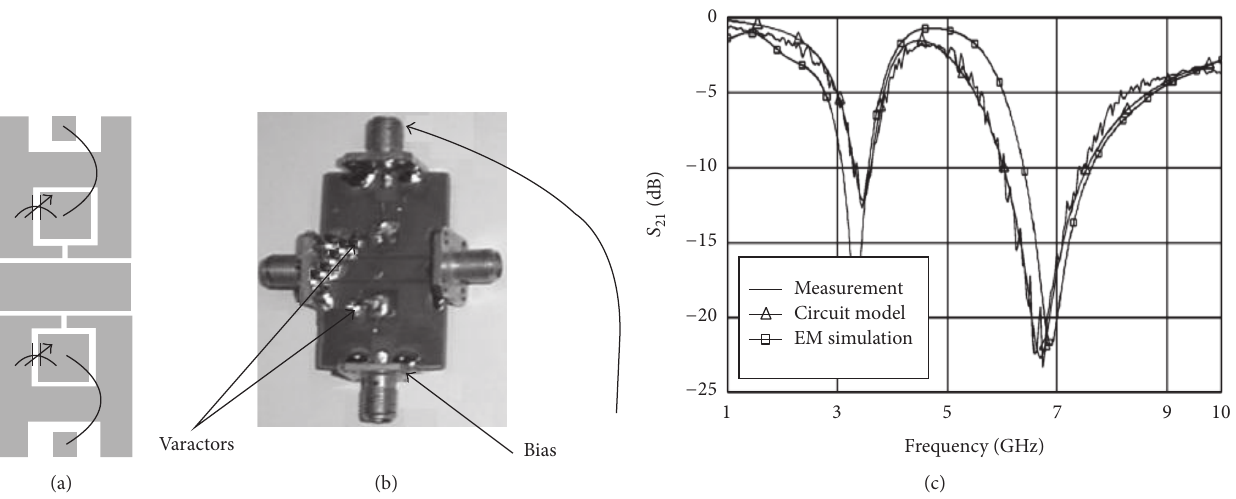
Figure 15: (a) Schematic of the tunable band-stop filter. (b) Fabricated M-DGS with the capacitors. (c) Measured, equivalent circuit model and EM simulation data [17].